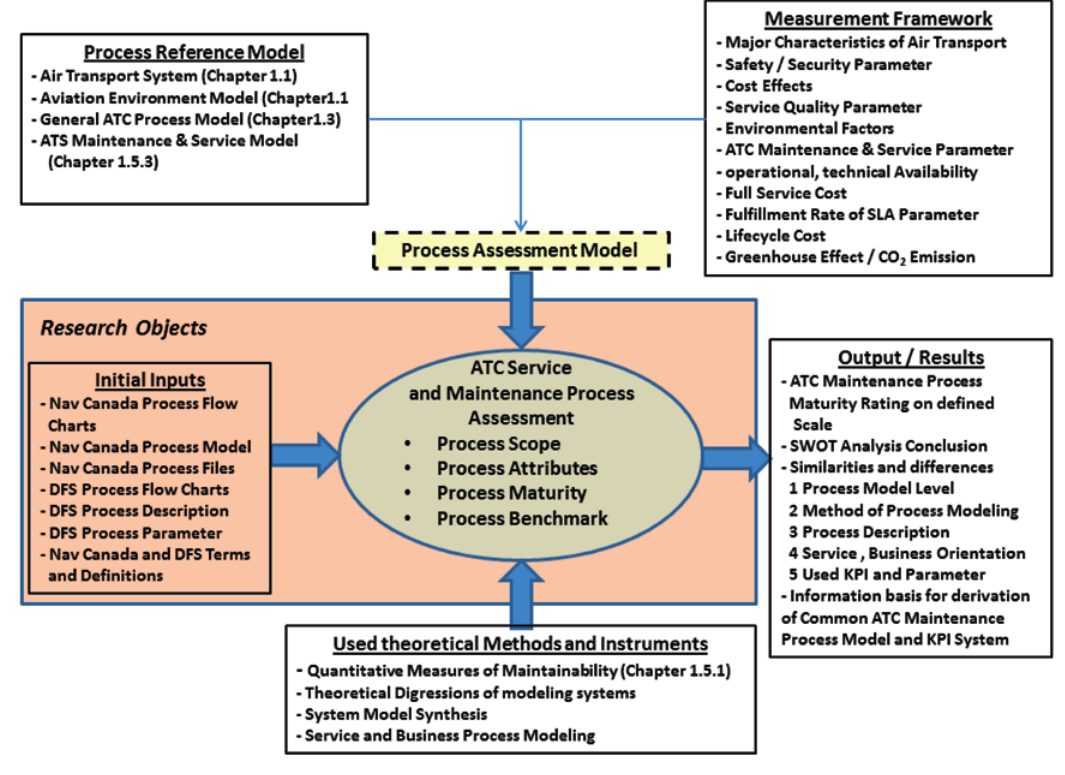
Fig. 1. Approach of ATC maintenance process